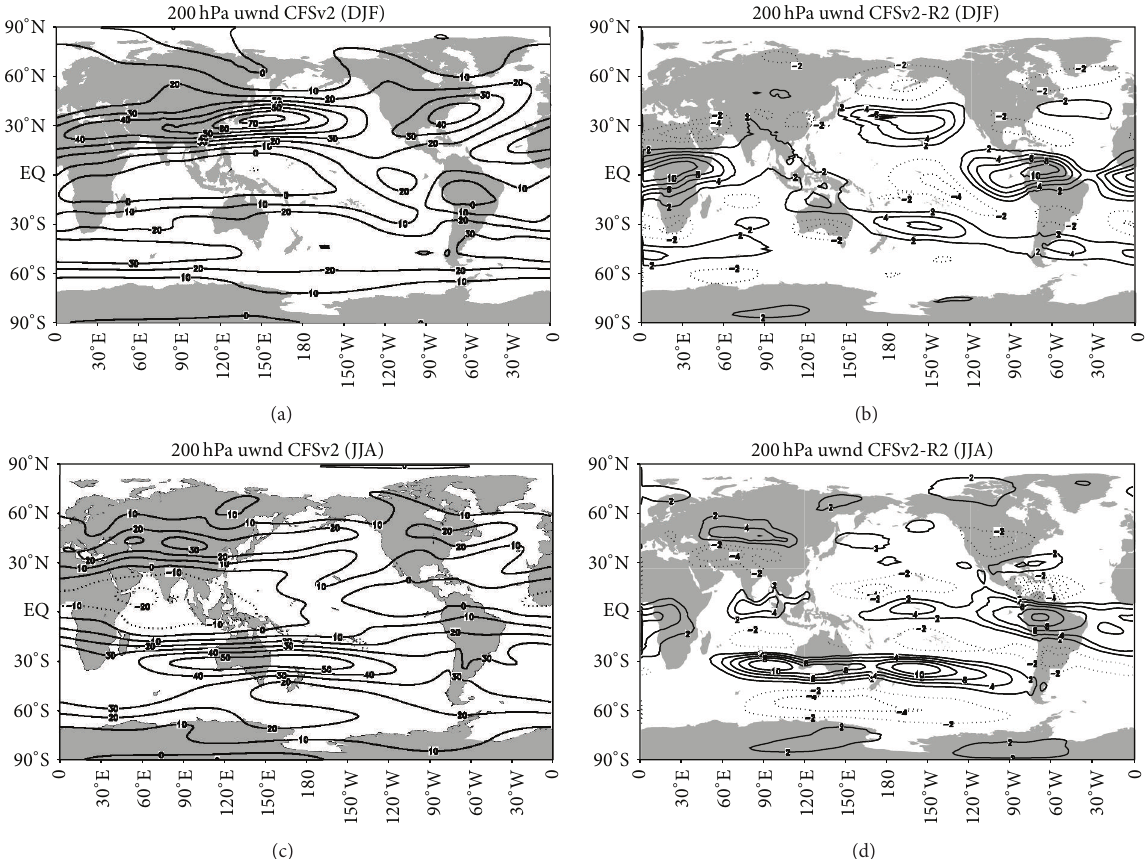
Figure 8: As in Figure 5, but for zonal wind at 200 hPa. Contours interval is 10m/s in (a) and (c) and 2m/s in (b) and (d). Negative contours are